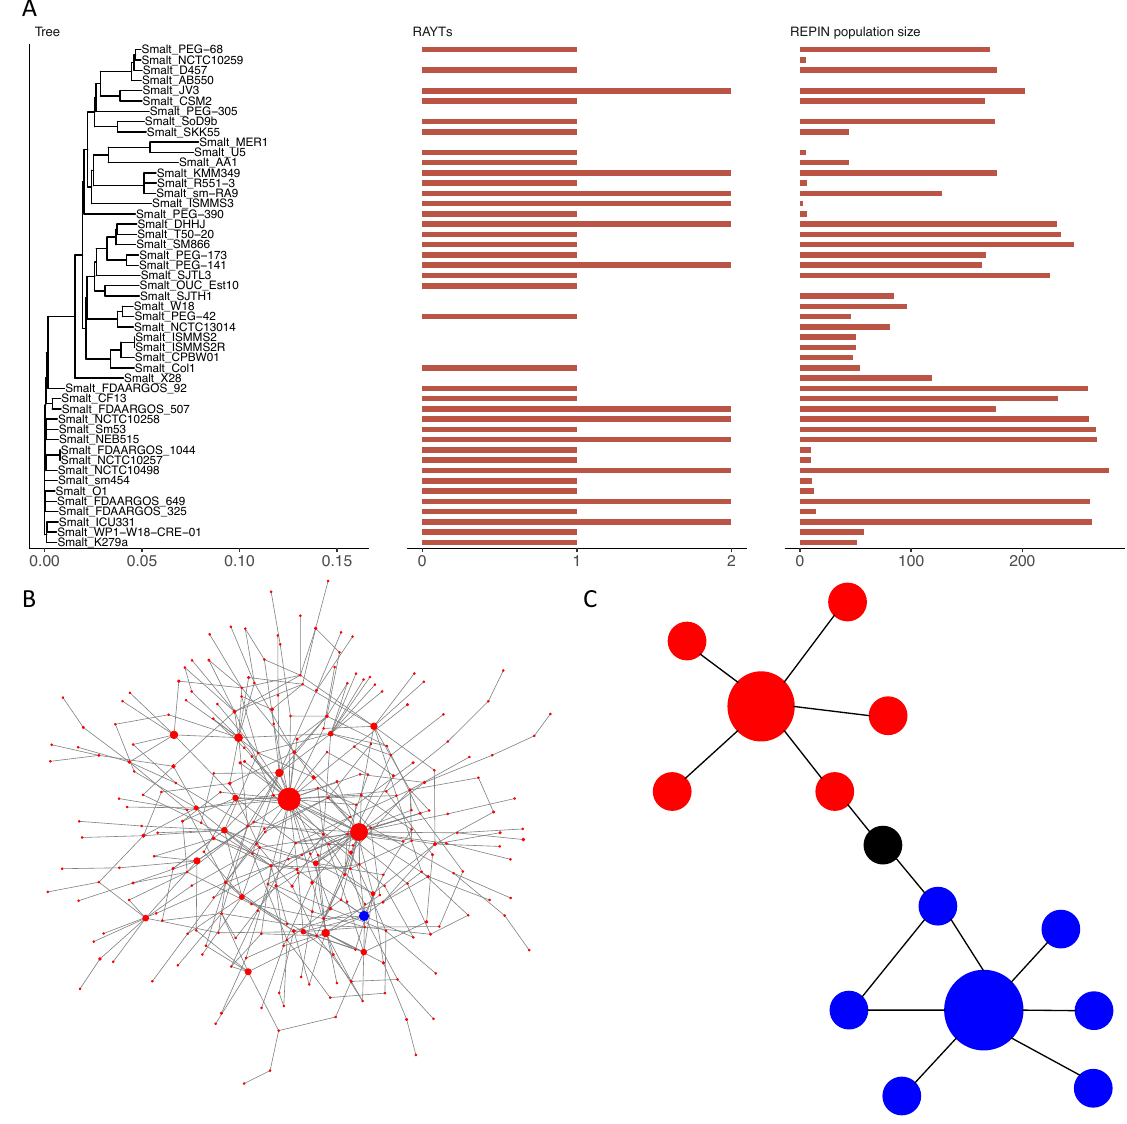
Figure 6 - Closely related REPIN populations may be merged by RAREFAN. (A) REPIN group 2 identified in a S. maltophilia Sm53 RAREFAN run. The RAREFAN result suggests that REPIN group 2 is sometimes associated with two RAYTs. ( B ) A closer inspection of the data shows that group 2 is a combination of two different REPIN groups, the “real” group 2 and group 0. The network shown, visualizes all REP sequences identified as group 2. Nodes in the network represent 21 bp long REP sequences. Two nodes are connected if the sequences they represent differ by exactly one nucleotide. The node size indicates the abundance of the sequence in the genome. The blue node represents the most common group 2 sequence, occurring 65 times in the genome. The largest red node occurs 407 times in the genome and resembles a group